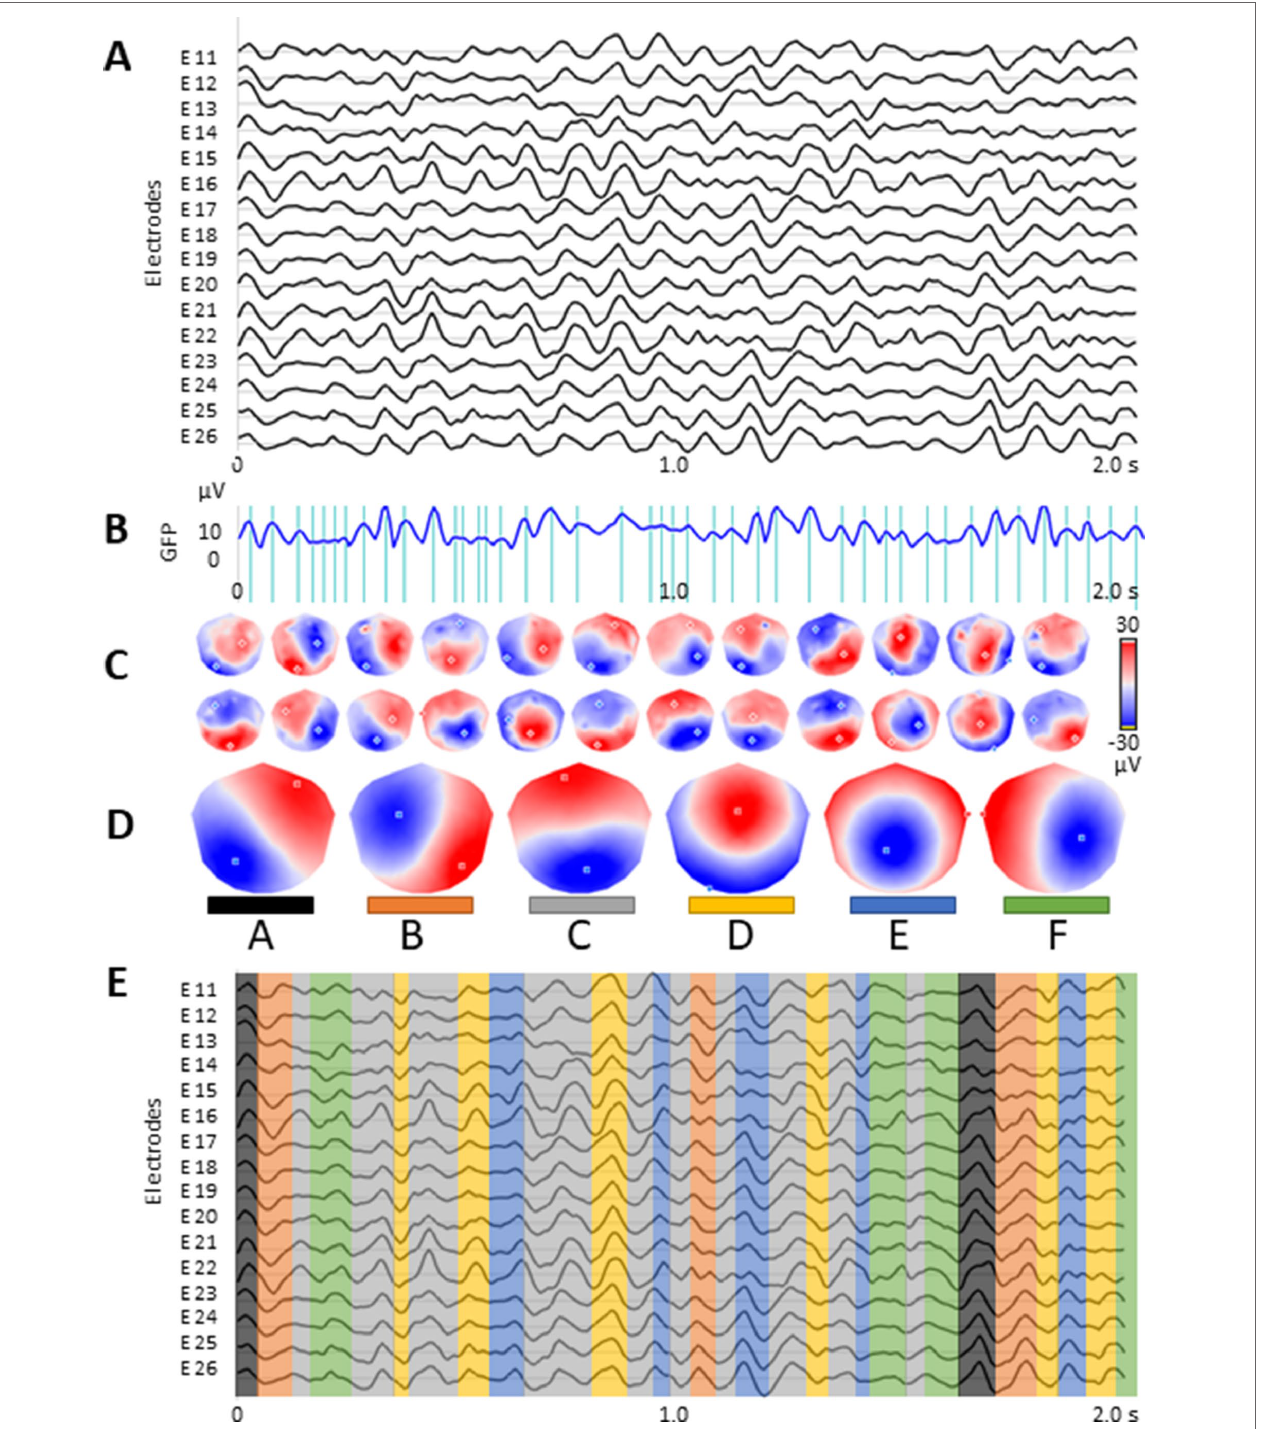
FIGURE 1 | Microstate analysis: (A) resting-state EEG from subsample of 16 out of 110 electrodes; (B) global field power (GFP) curve with the GFP peaks (vertical lines) in the same EEG period as shown in (A) ; (C) potential maps at successive GFP peaks, indicated in (B) , from the first 1 s period of the recording; (D) set of six cluster maps best explaining the data as revealed by K-means clustering of the maps at the GFP peaks; (E) the original EEG recording shown in (A) with superimposed color-coded microstate segments. Note that each time point of the EEG recording was labelled with the cluster map, shown in (D) , with which the instant map correlated best. The duration of segments, occurrence, and coverage for all microstates were computed on thus labeled EEG